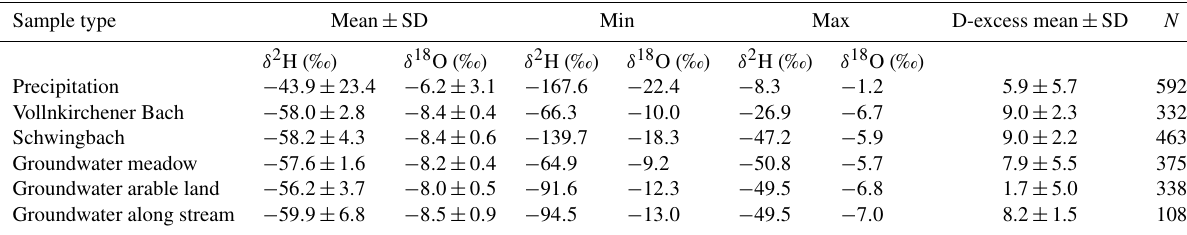
Table 1. Descriptive statistics of δ 2 H, δ 18 O, and d-excess values for precipitation, stream, and groundwater over the 2-year observation period including all sampling